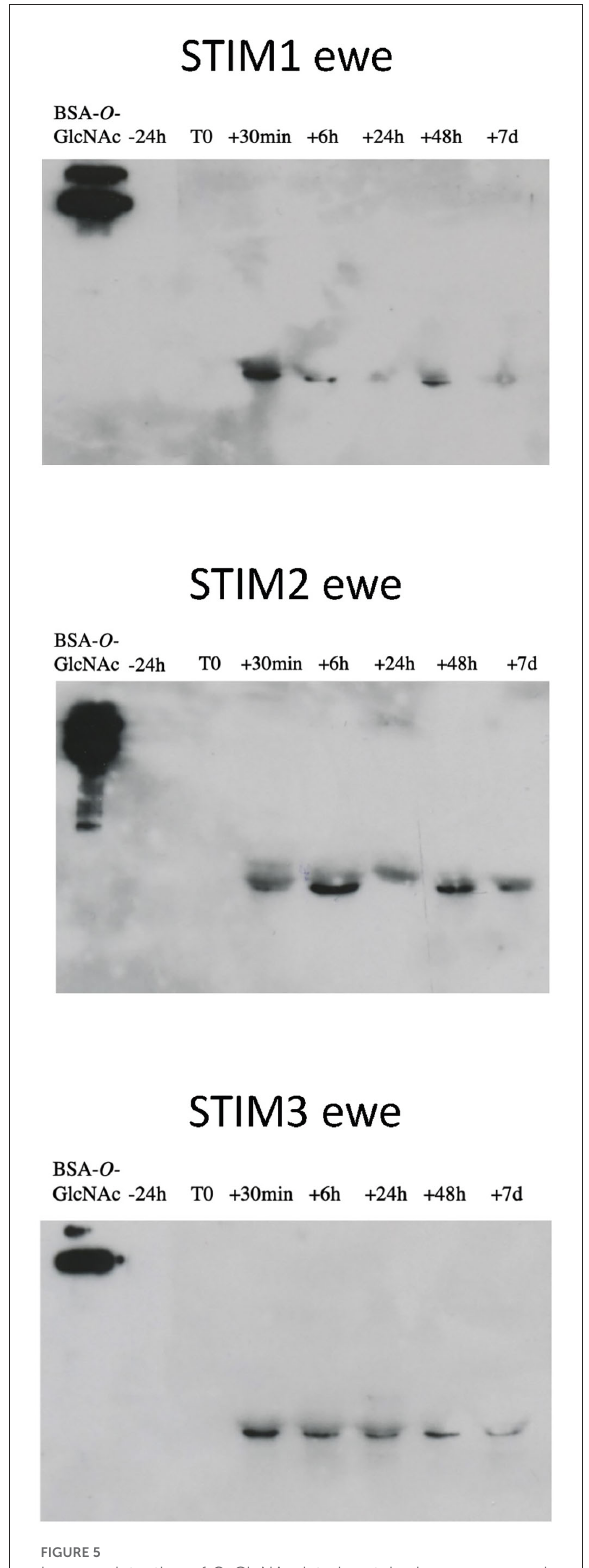
FIGURE5 Immunodetection of O -GlcNAcylated proteins in ewes exposed to the male. Western-blot with CTD110.6 antibody (1/5,000) on proteins of nasal mucus (15 micrograms per well) sampled during a ram effect. ECL detection, 10min